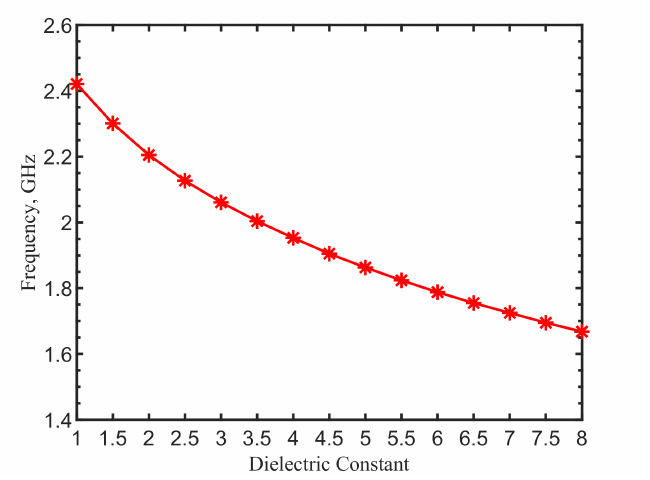
Figure 17. Resonant frequencies as a function of substrate dielectric constant from 1 to 8 for the loop resonator ( U =9, b = 20.9 mm, a = 1.44 mm).